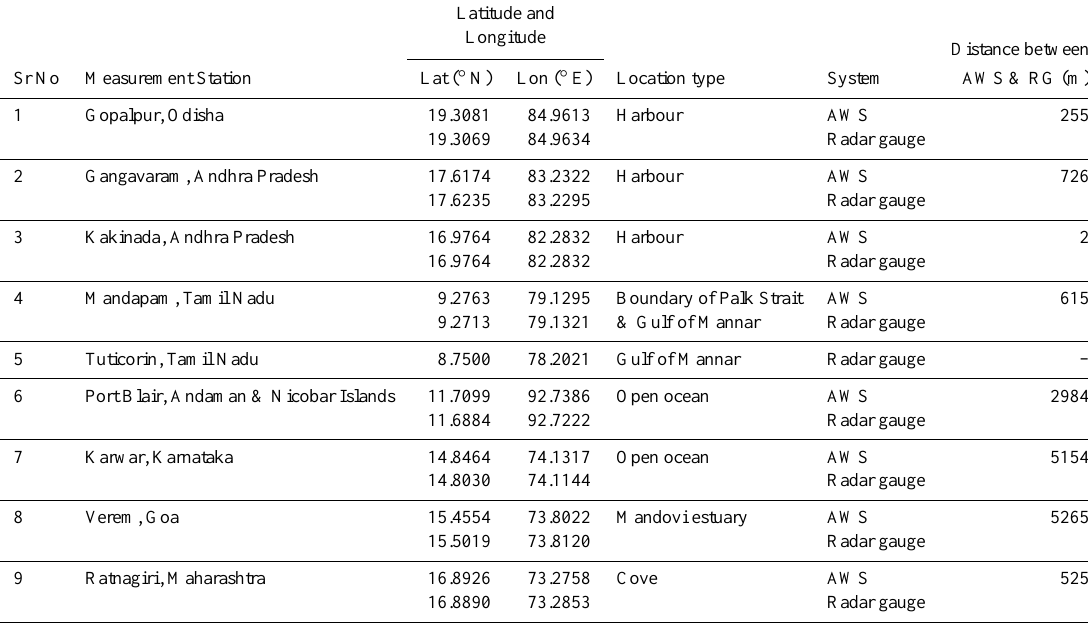
Table 1. Summary of observations from different coastal and Island locations of India from 1 September 2011 to 31 January 2012. The CSIR-NIO radar gauge (RG) measures sea level (cm) and the CSIR-NIO autonomous weather station (AWS) provides surface meteorological variables such as winds, atmospheric pressure and air